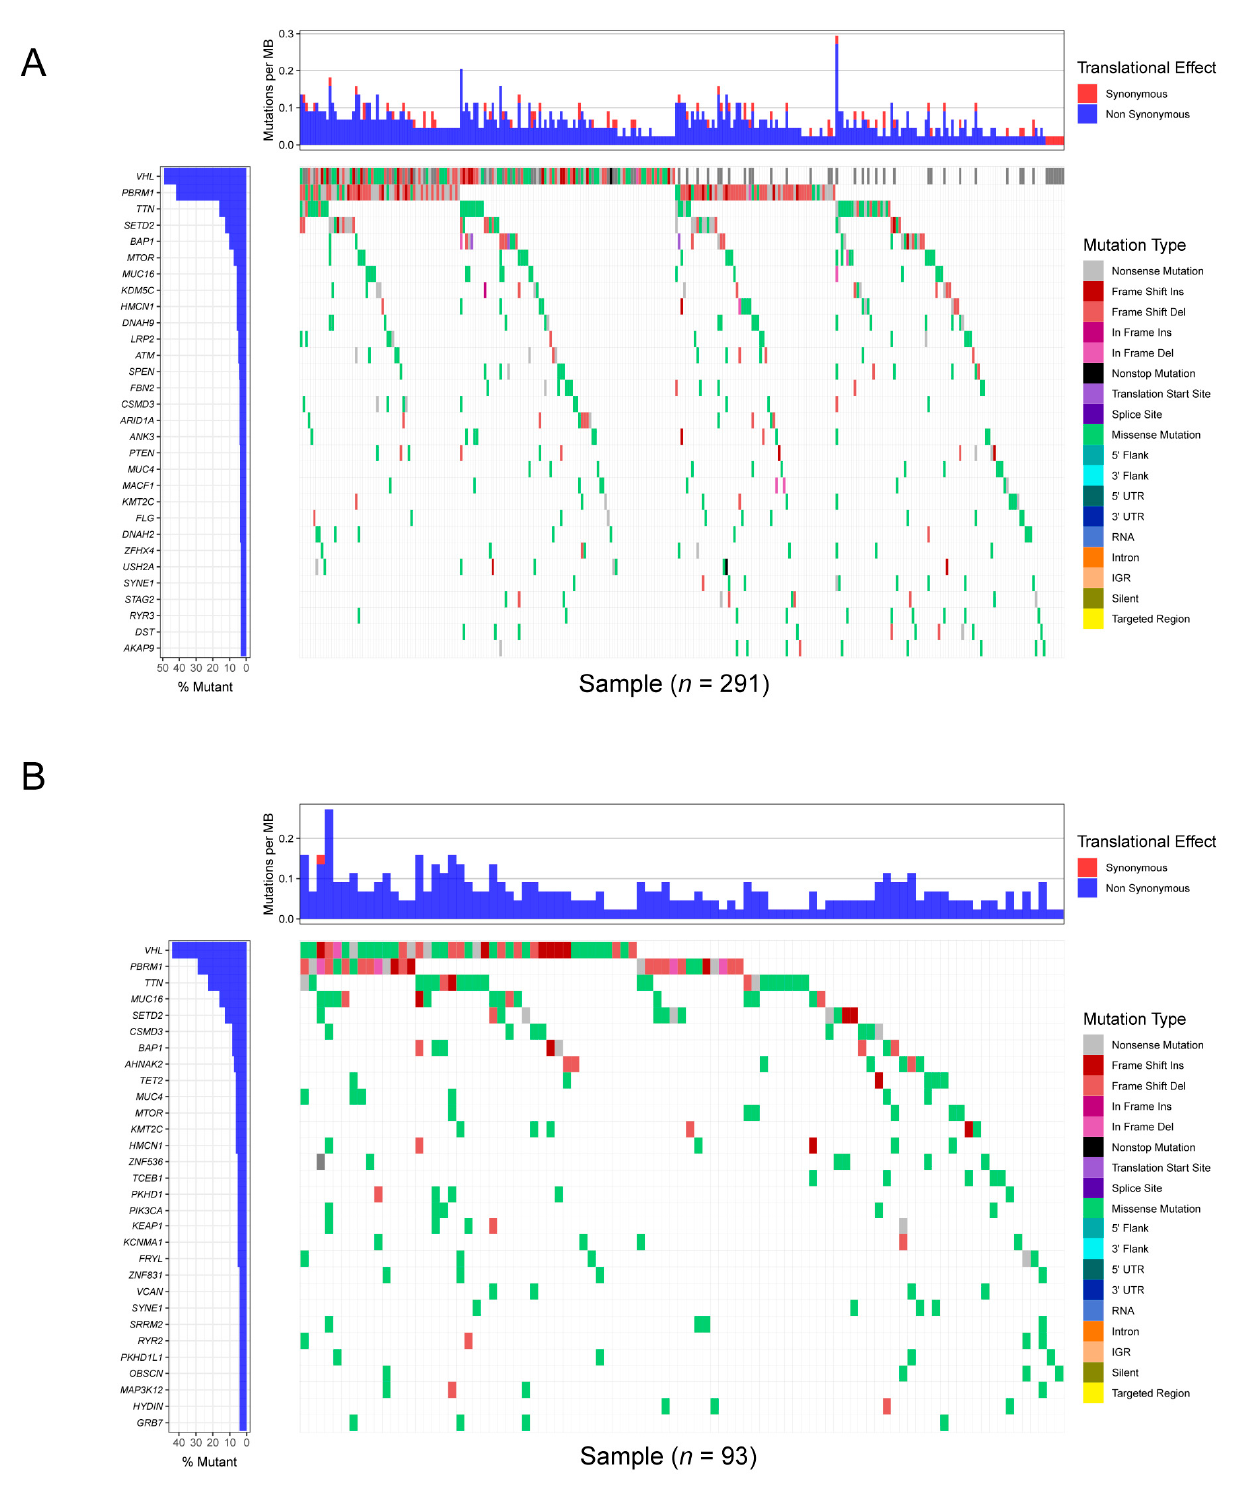
Figure 2. Profile of frequently mutated genes in KIRC. ( A ) Waterfall plot illustrating the top 30 genes in TCGA cohort. ( B ) Waterfall plot demonstrating the top 30 genes in UTokyo cohort.